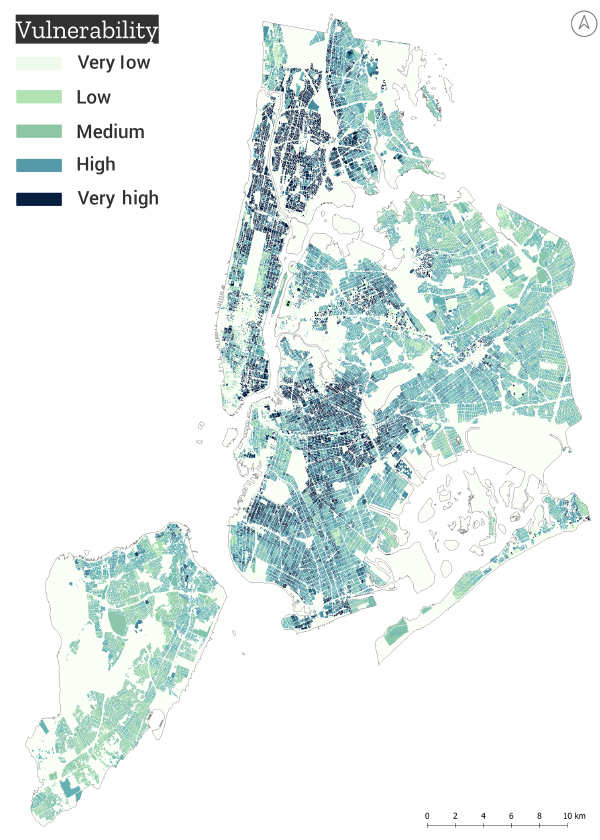
Figure 5. Map of